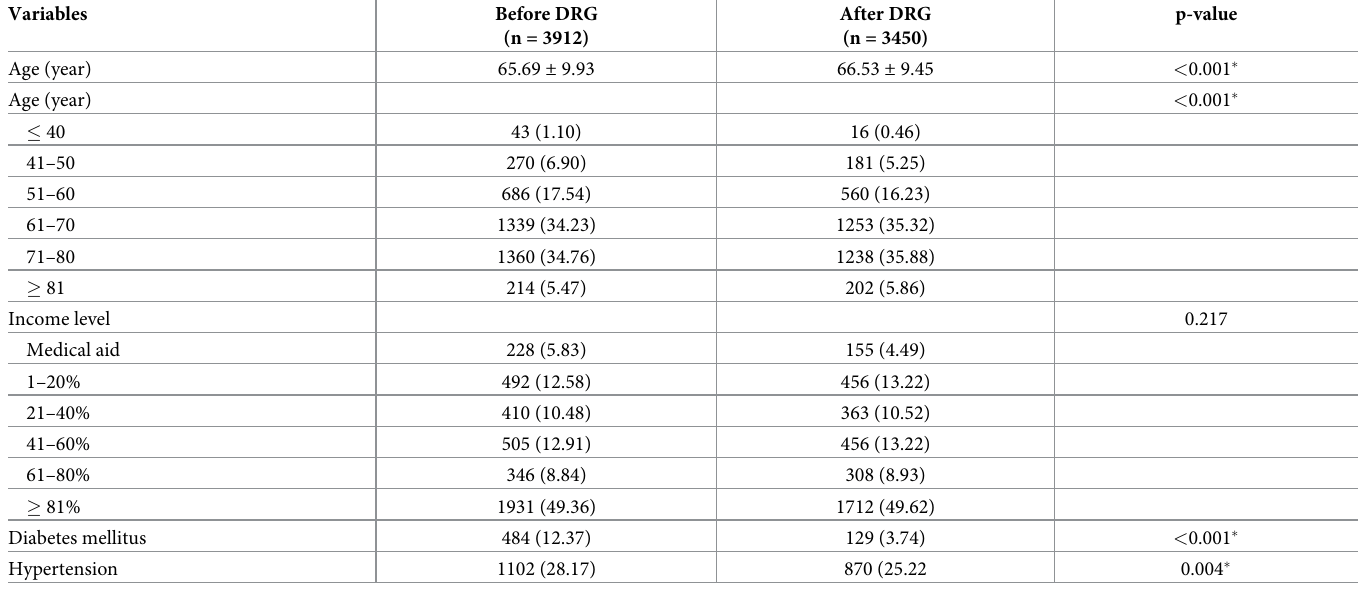
Table 2. Characteristics of the study